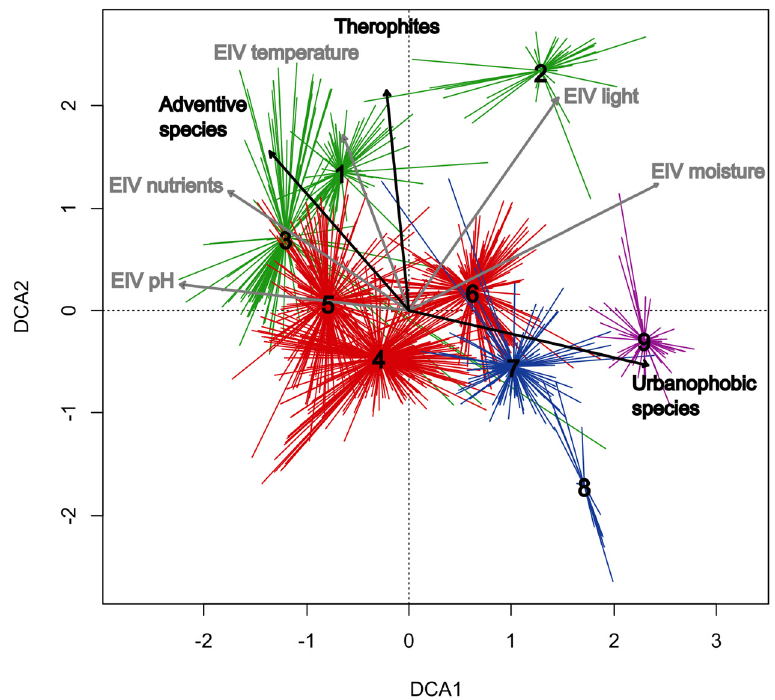
Figure 2. DCA spider plot of the final dataset (1086 relevés). Centroids of clusters are indicated by numbers corresponding to Table 1, Figures 3–4, Tables S1–S4, Appendix C and to those used in the